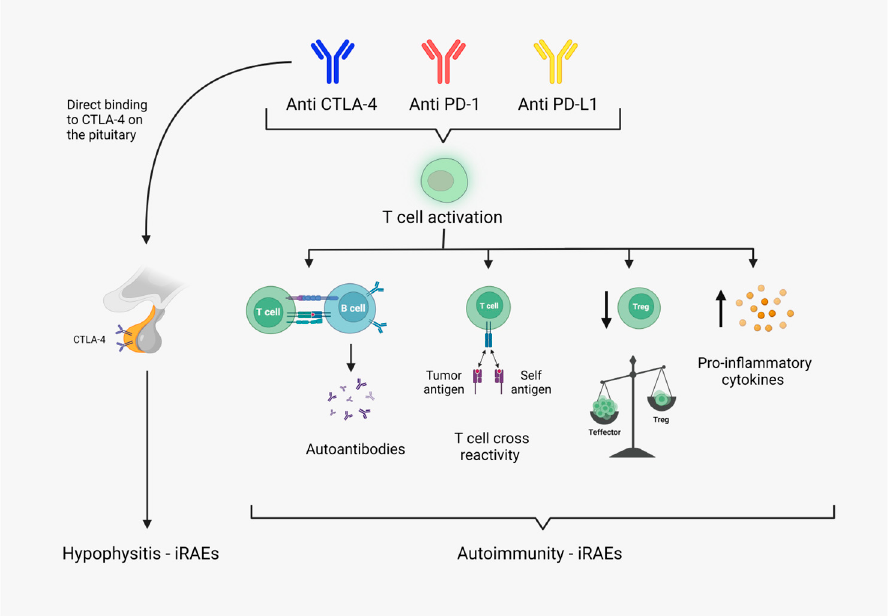
Figure 2. Possible pathophysiology of immune-related adverse effects: Immune checkpoint inhibitors induce T cell activation, thus enhancing the immune response to tumor cells. The resulting activation of cellular and humeral response is postulated to be the major cause of immune-related adverse effects. Non-specific activation of T cells leads to uncontrolled pro-inflammatory cytokine release and established inflammatory environment. T cell equilibrium leans toward effector T cells and downregulation of regulatory T cells. Suppression of Tregs results in loss of peripheral tolerance and subsequent auto-reactivity. Tumor-specific T cells cross-react with self-antigens on healthy cells. Overstimulation of T cells enhances T cell-B cell interaction and antibody production. Production of autoantibodies has been shown to mediate several organ-specific irAEs. Direct attack of anti-CTLA antibodies against physiologically expressed CTLA-4 on anterior pituitary cells. (This figure was created based on the tools provided by Biorender.com, accessed on 9 November